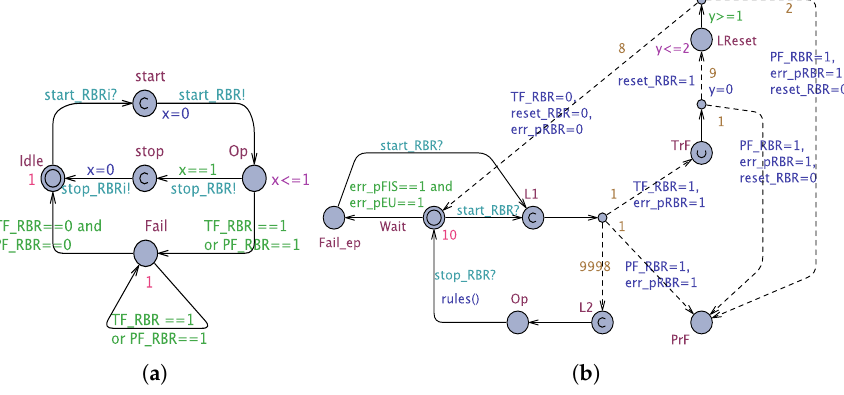
Figure 9. The STA for the RBR. ( a ) Interface STA ( RBR iSTA ); ( b ) Annex STA ( RBR aSTA